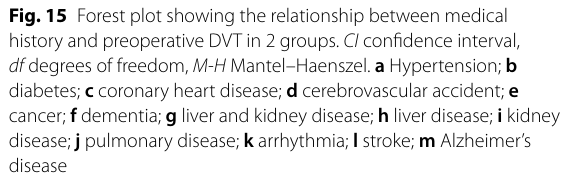
Fig. 15 Forest plot showing the relationship between medical history and preoperative DVT in 2 groups. CI confidence interval, df degrees of freedom, M-H Mantel–Haenszel. a Hypertension; b diabetes; c coronary heart disease; d cerebrovascular accident; e cancer; f dementia; g liver and kidney disease; h liver disease; i kidney disease; j pulmonary disease; k arrhythmia; l stroke; m Alzheimer’s disease